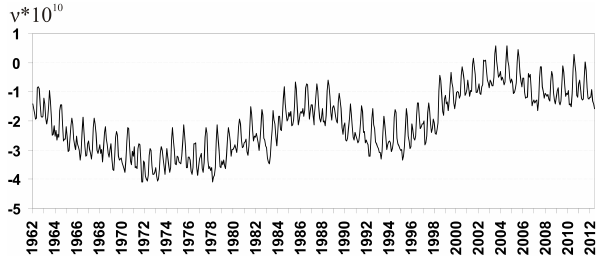
Fig. 6. The time series of the monthly averaged values of relative an- gular velocity of the Earth’s rotation ( ν ) during the last 50yr, where ν ≈ ( T − P)/P ; here T is the Earth length of day (s), and P is the astronomical day – 86400s. The vertical axis gives ν × 10 10 .